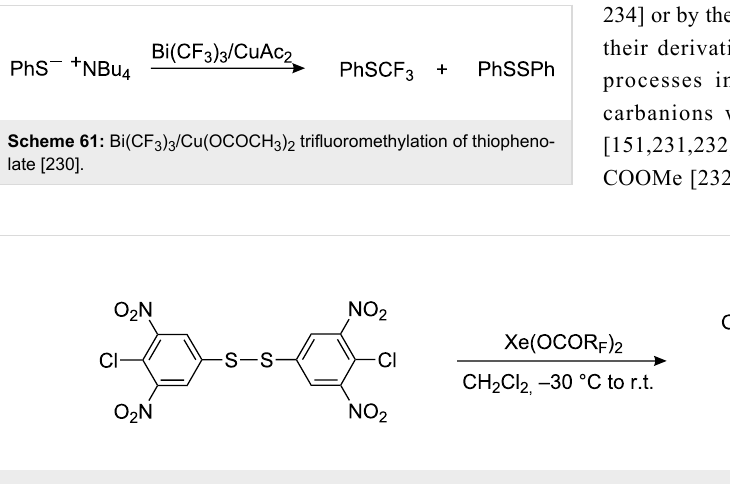
Perfluoroalkylsulfinic acids can also be used for